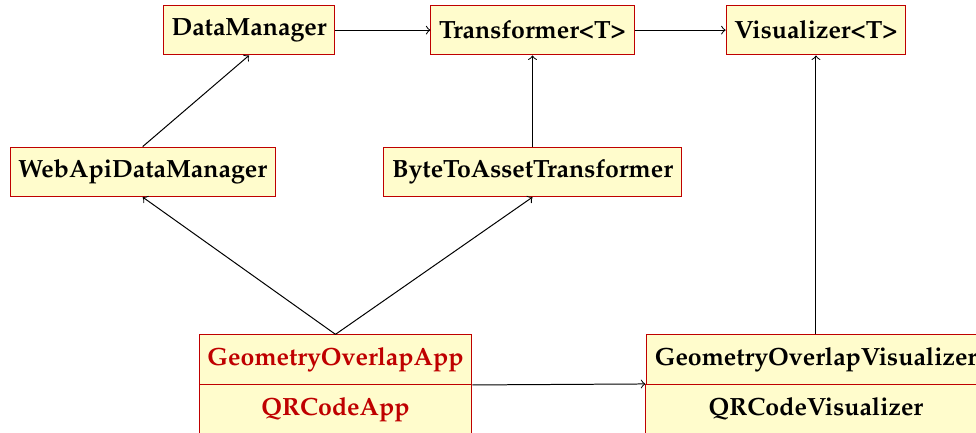
Figure 15. Overview of the classes that are currently implemented in the library and how they relate to each other. The red classes are the case classes implementing the library and managing the